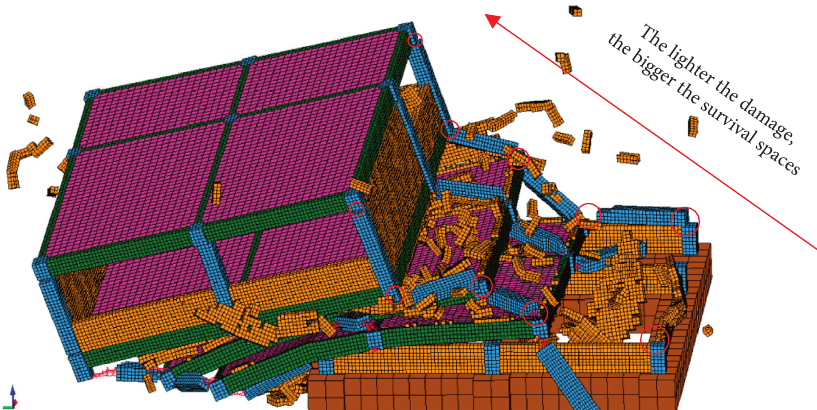
Figure 54: The distribution of vertical survival